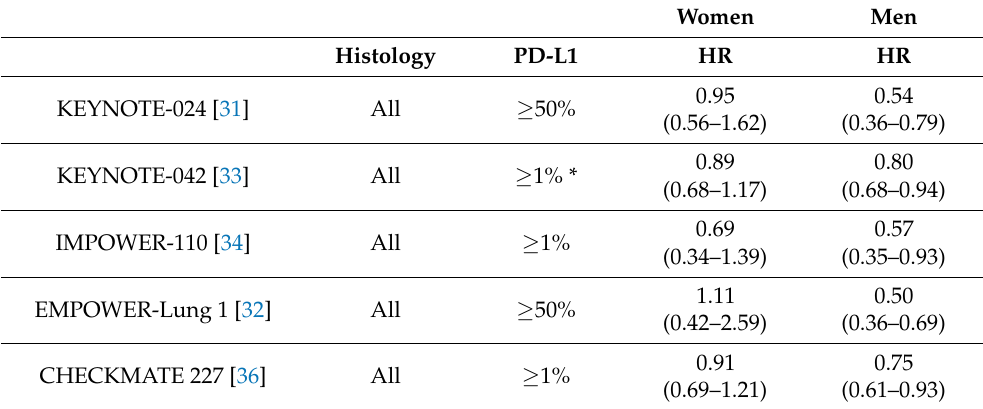
Table 1. List of phase 3 trials of approved immunotherapy schemes not containing chemotherapy in first-line treatment of non-small cell lung